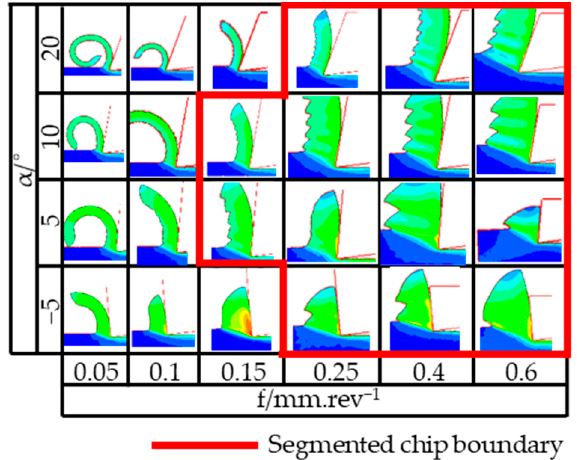
Figure 9. Continuous chip to segmented chip transition prediction predicted by the JC flow stress model in combination with the JC Fracture model. Note: Image magnification not to scale.